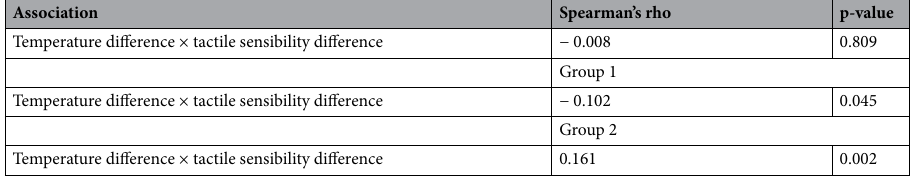
Table 2. Spearman’s correlation of temperature and tactile sensibility differences in the feet. Group 1: Patients without the subjective perception of temperature differences between both sides of the body; Group 2: Patients with the subjective perception of temperature differences between both sides of the body.